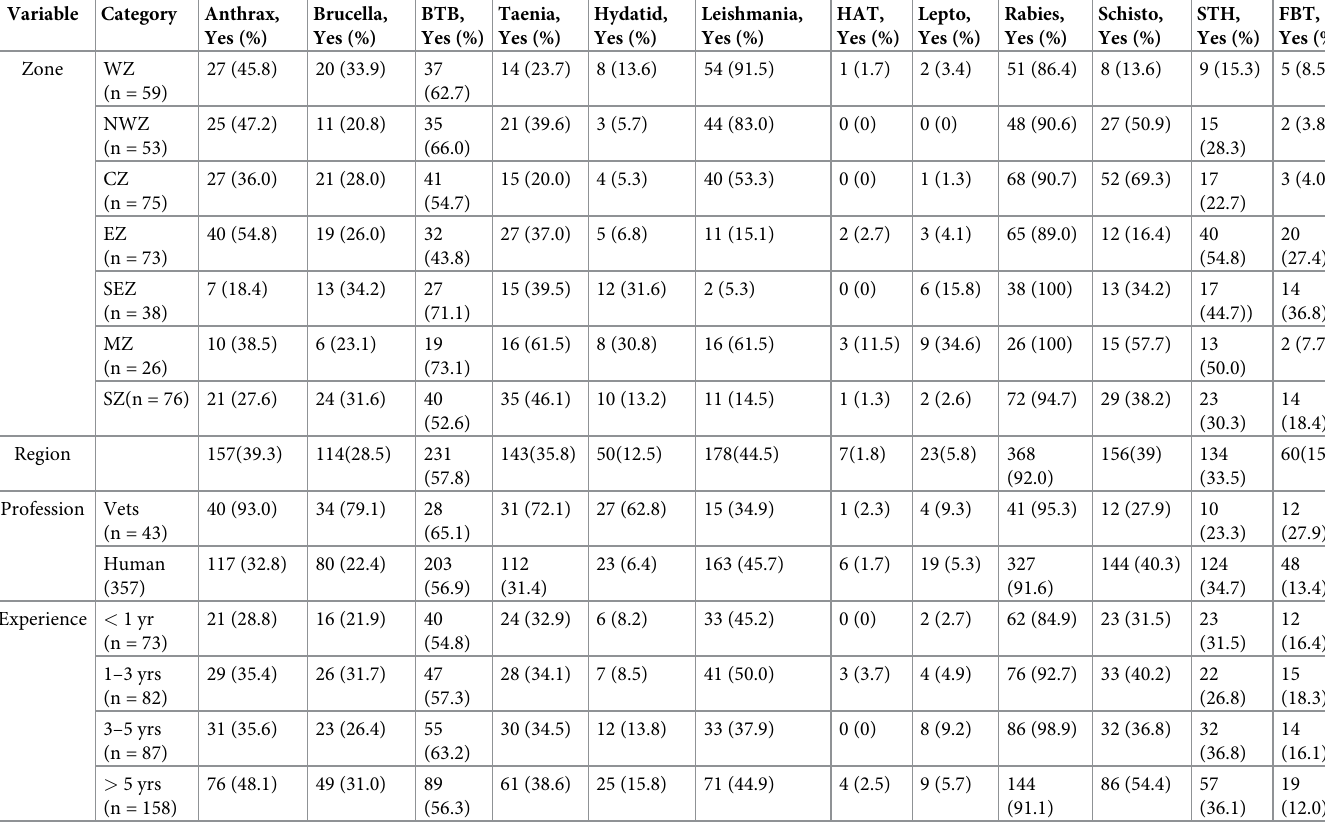
Table 2. Zonal distribution of major NTZDs and comparisons with profession and working experience. Variable Category Anthrax, Yes